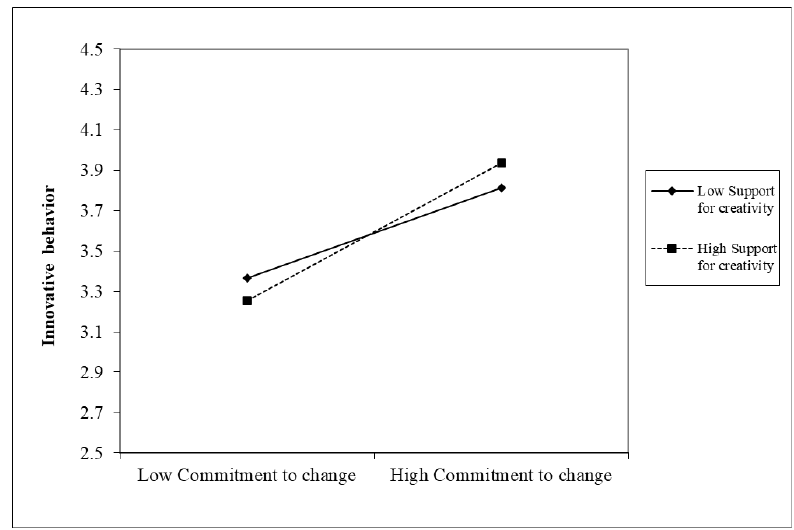
Figure 2. Interaction effects of support for creativity on innovative behavior (self-reported). Table 6. Regression analyses of IB (performance) for the mediator and moderator.